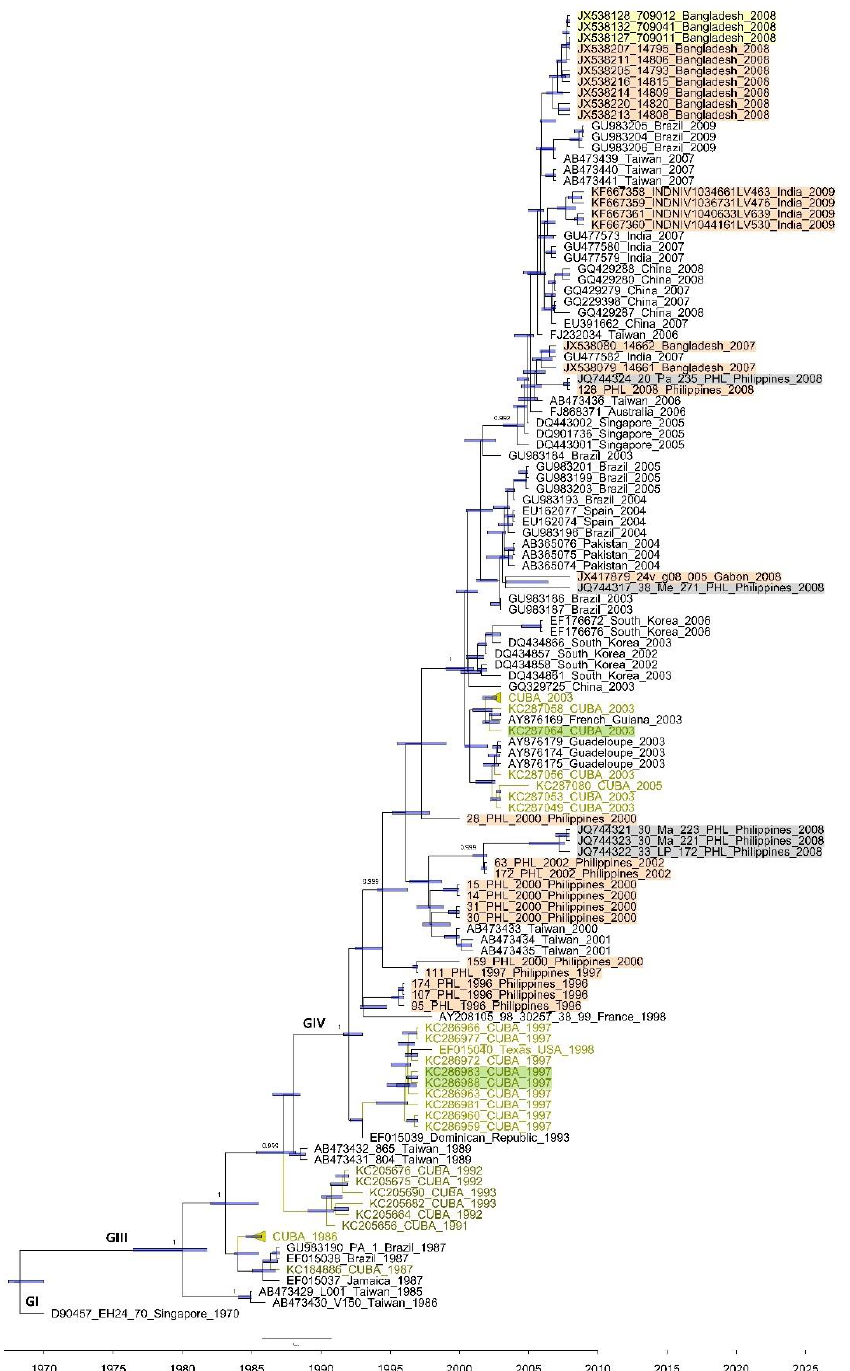
Figure 2. Maximum clade credibility (MCC) phylogeny of the VP1 (234 nucleotides) coding region of 35 Cuban (in green) and 95 worldwide CVA24v strains constructed by Bayesian method with the Bayesian Evolutionary Analysis Sampling Tree (BEAST) v1.8.4 program. Bars at nodes indicate with a 95% highest posterior density (HPD) the time of the most recent common ancestor (TMRCA). Support values with a posterior probability >0.700 are indicated at the nodes. Branches forming genotypes GI-GIV are shown. The sequences are indicated by the GenBank accession number, strain name, coun- try, and year of isolation. Cuban sequences obtained from feces isolates of AHC patients ( n = 3) are highlighted in green; sequences obtained from Synanthropic nonhuman primate feces isolates ( n = 3) are highlighted in yellow [27]; the se- quences obtained from acute flaccid paralysis (AFP) feces isolates ( n = 27) are highlighted in orange [27,28 – 30]; and the sequences obtained from Philippines river samples ( n = 5) are highlighted in grey [31].